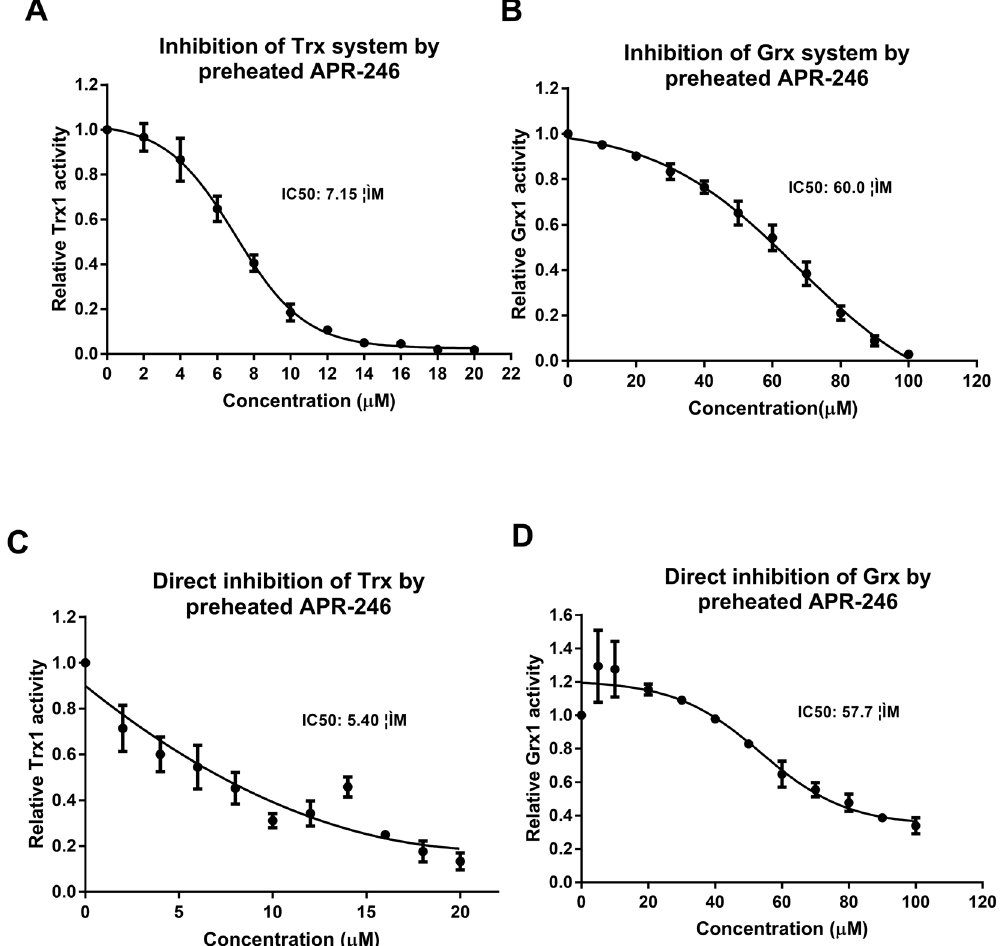
Figure 2. Comparison of the inhibition of the hTrx1 and hGrx1 systems with the inhibition of individual Trx1 and Grx1 by APR-246. ( A ) Inhibition of the Trx system by preheated APR-246. The thioredoxin system (50 nM TrxR1, 0.1 µ M Trx, and 0.25 mM NADPH) was incubated with preheated APR-246 (2–20 µ M) for 60 min. Trx activity was then assessed by the FITC-insulin coupled method to measure IC 50 value. Results are shown as means ± SD of three experiments. ( B ) Inhibition of the Grx system by preheated APR-246. The GSH-Grx system (0.25 mM NADPH, 50 nM yeast GR, 50 µ M GSH 0.1 µ M Grx1) was incubated with pre-heated APR-246 (10–100 µ M) for 60 min. Grx1 activity was then assessed by the E-GS-BSA coupled method. Results are shown as means ± SEM of three experiments. Inhibition of Trx1 ( C ) and Grx1 ( D ) by preheated APR-246. Trx1 and Grx1 were prereduced with 10 mM DTT and desalted prior to 60 min incubation. The mixtures were then added onto 96-well plates along with the remaining components of the respective systems to measure the activity as described above. Results are shown as means ± SEM of three